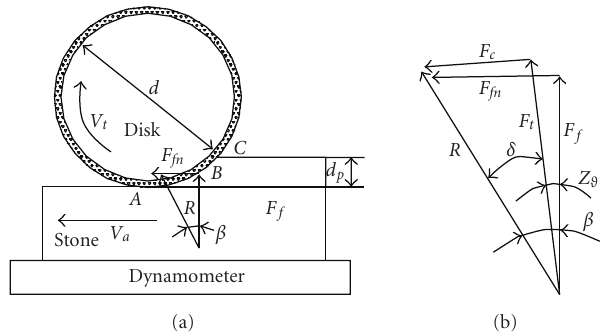
Figure 2: (a) F f and F fn measurements by dynamometer; (b) F t and F c force